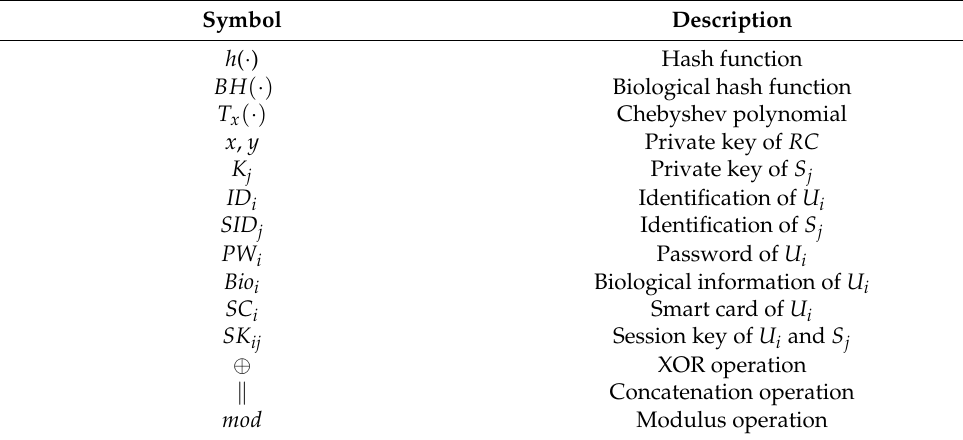
Table 3. Notations in Chatterjee et al.’s